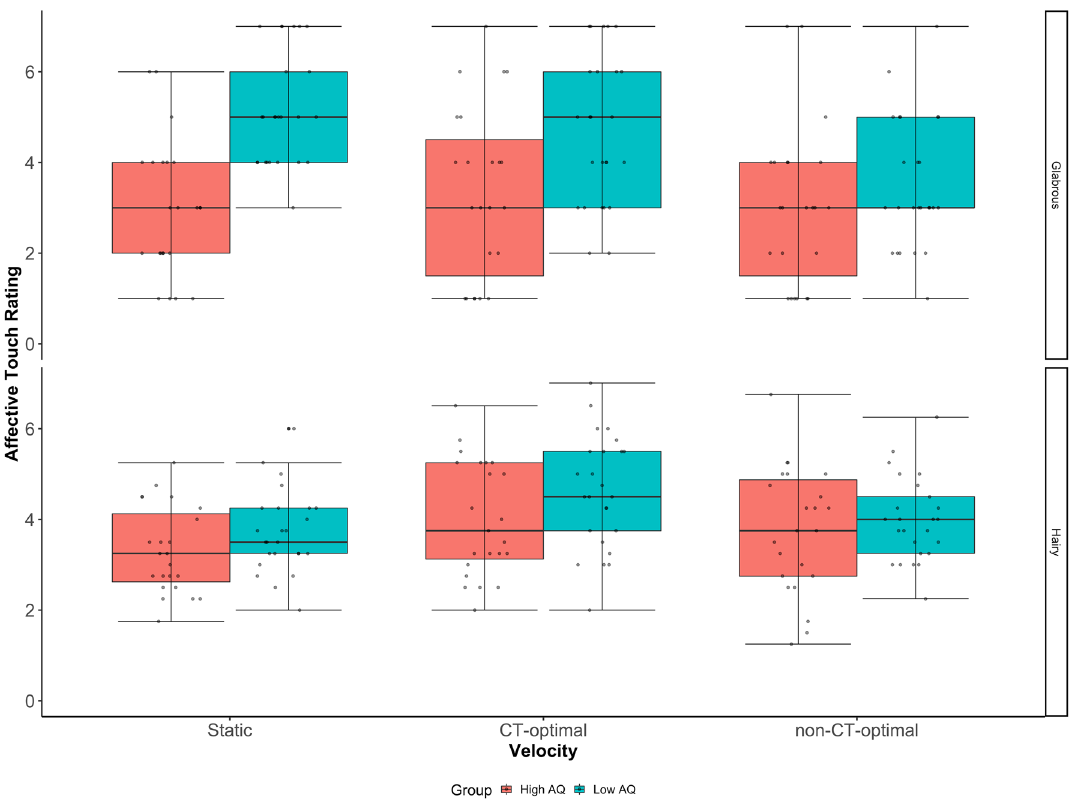
Figure 4. Box plot showing the difference between groups for CT vs nonCT velocities in the ratings of touch on the hairy (Back and Arm) and glabrous (palm) skin locations. Participants with the highest number of autistic traits rate touch to the Palm significantly lower than individuals with the lowest number of autistic traits for both Static and CT-optimal velocities (bars ± 95%